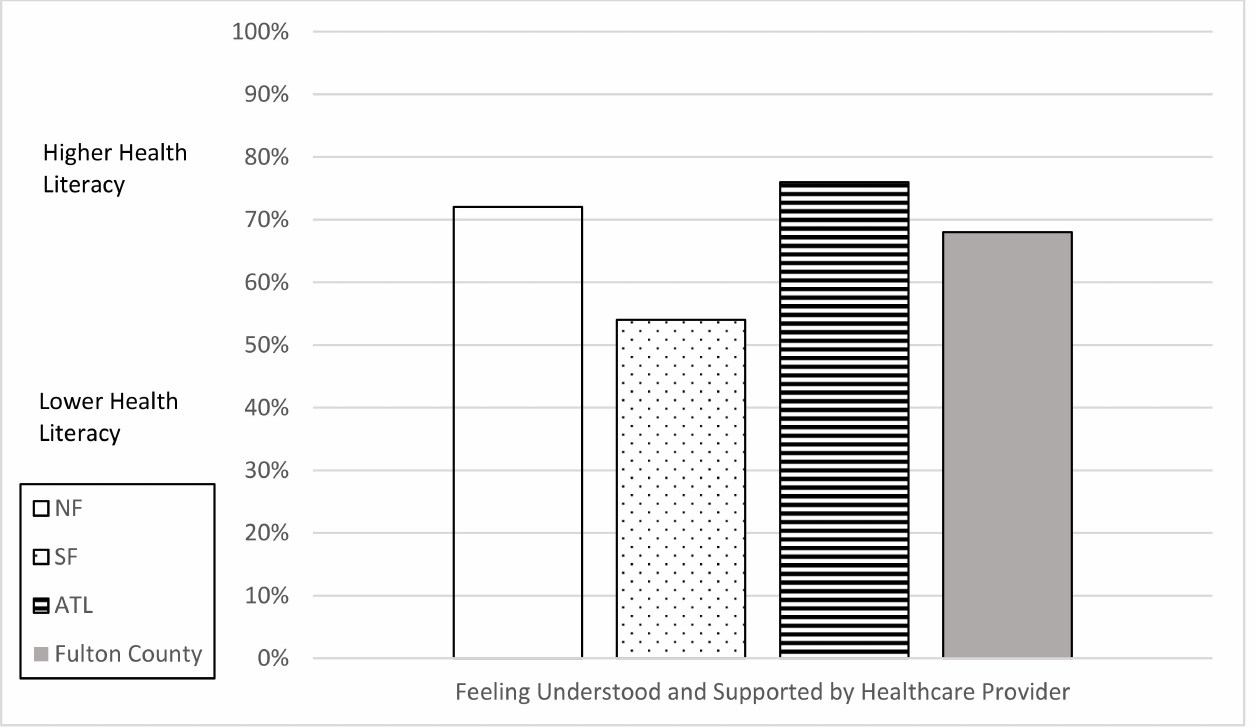
Figure 3. Organizational Health Literacy Scale (cut point 50%) by County Area: Understood and Sup- ported by Provider. Based on Level of Agreement (lower = strongly disagree/disagree; higher = agree/ strongly